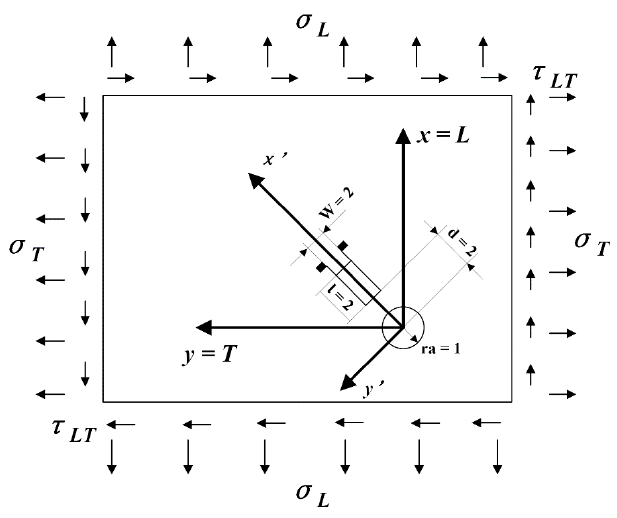
Figure 9. Schematic illustration of the plane coordinate system.